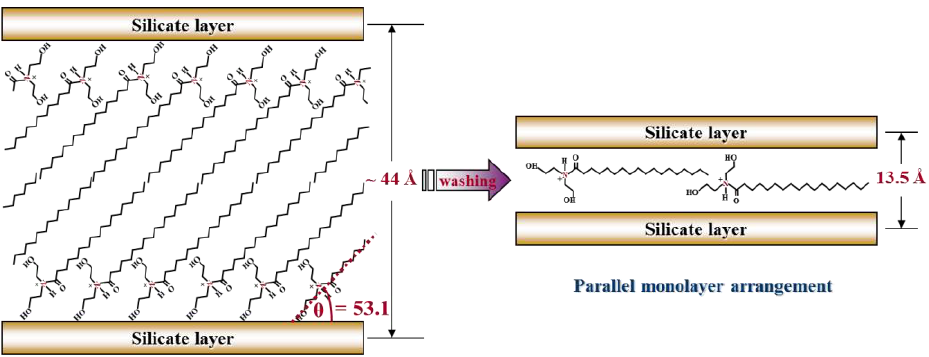
Figure 4. Proposed interlayer structure of the CDEA – montmorillonite nanocomposite.